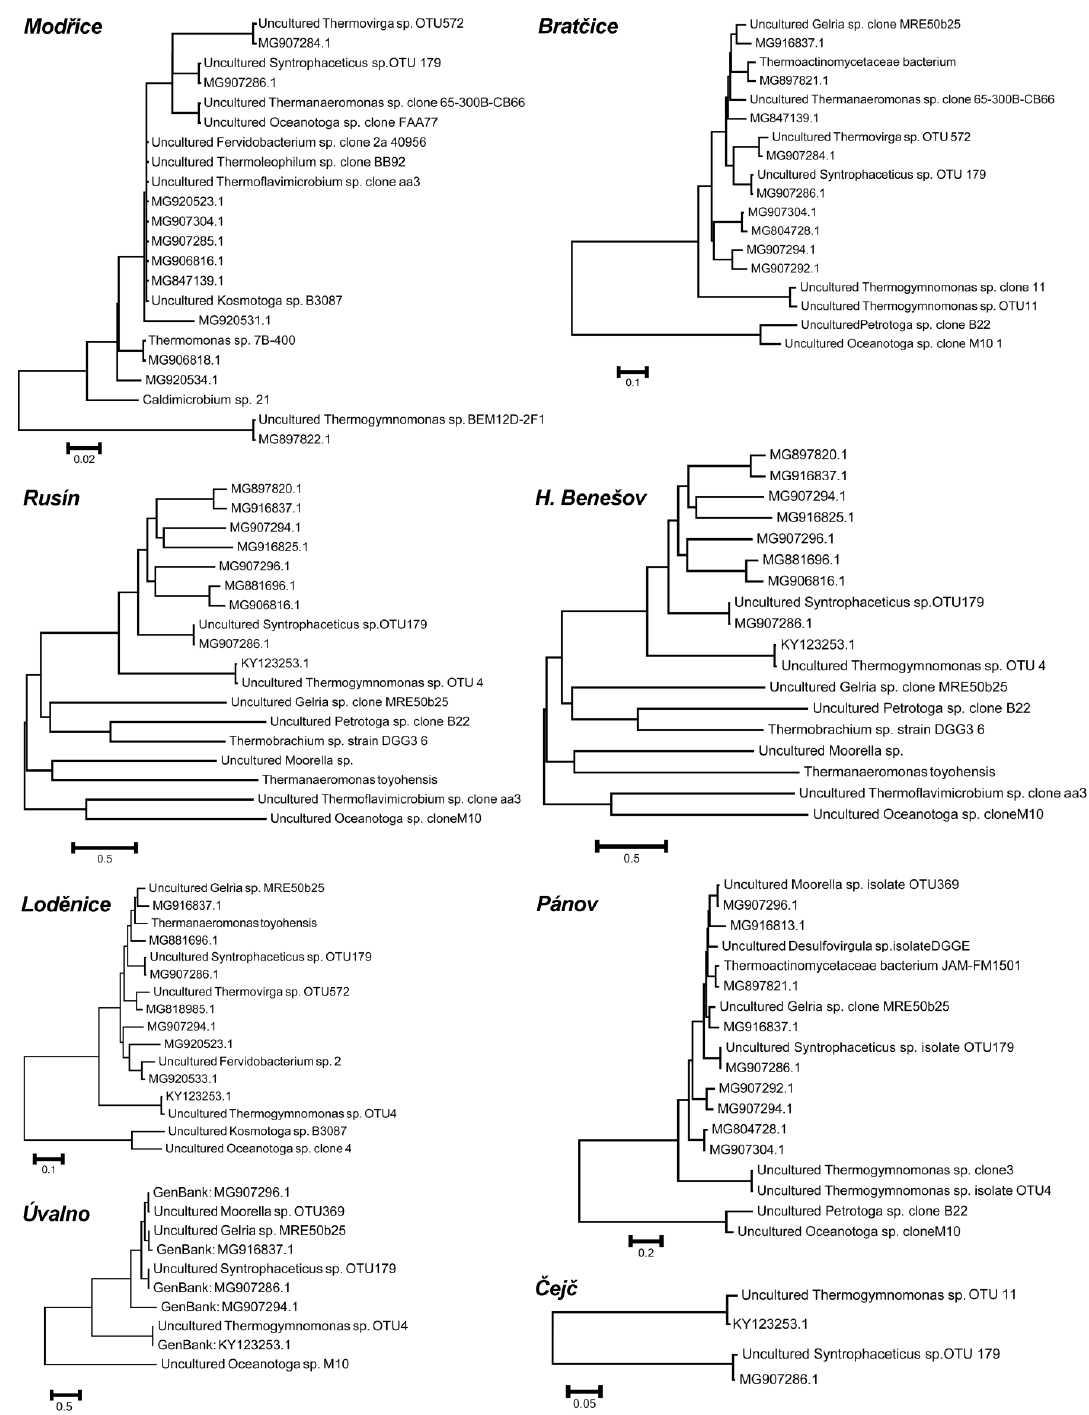
Figure 6. Phylogenetic trees showing thermophilic microorganisms found in the anaerobic fermenters.